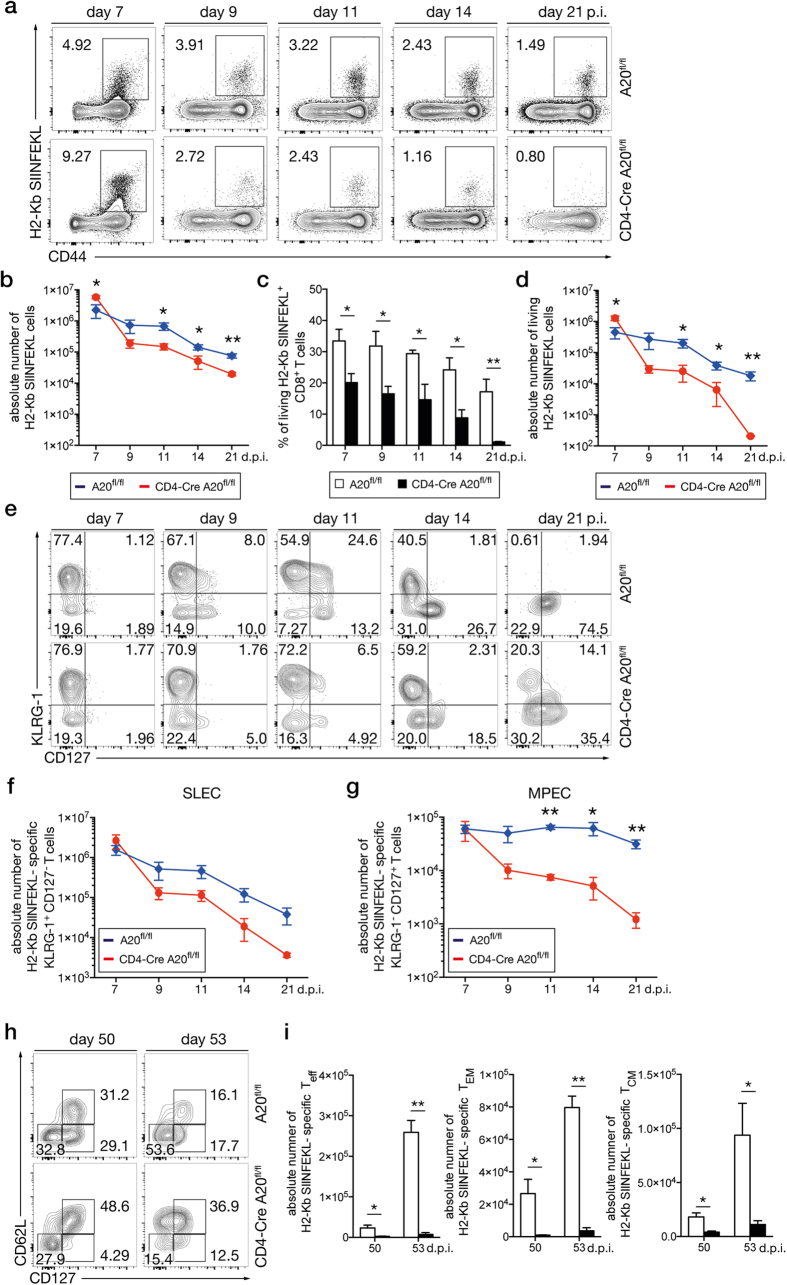
Reduced numbers of memory and memory-precursor CD8+ T cells in CD4-Cre A20fl/fl mice.CD4-Cre A20fl/fl and A20fl/fl control mice were infected with a non-lethal dose of Lm OVA and spleens were analyzed for Tmem formation at the indicated time points. (a) Kinetic of Lm OVA-specific CD8+ T cells, stained with H2-Kb SIINFEKL pentamer and gated on singlets and CD3+ CD8+ cells. (b) Absolute numbers of total (living, apoptotic and necroptotic) Lm OVA-specific CD8+ T cells. (c) Relative numbers of living (annexin−/7-AAD−) Lm OVA-specific CD8+ T cells. (d) Absolute numbers of living (annexin−/7-AAD−) Lm OVA-specific CD8+ T cells. (e) Representative dot plots with frequencies of Lm OVA-specific CD8+ SLEC (KLRG-1+ CD127−) and MPEC (KLRG-1− CD127+) were determined. (f) Absolute numbers of Lm OVA-specific CD8+ SLEC. (g) Absolute numbers of Lm OVA-specific CD8+ MPEC. (h) Representative dot plots with frequencies of Teff (CD62Llow and CD127low), TEM (CD62Llow and CD127high) and TCM (CD62Lhigh and CD127high) were determined at day 50 and 53 p.i. (i) Absolute numbers of Lm OVA-specific CD8+ Teff, TEM and TCM cells. Data are compiled of 2 independent experiments with 3–5 animals per group and experiment. Error bars indicate + SEM. Student’s t-test, *p < 0.05; **p < 0.01.